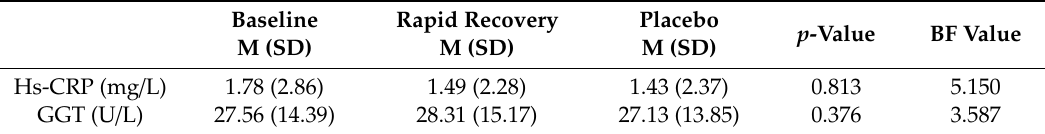
Table 3. High sensitivity C-reactive protein (hs-CRP) and gamma-glutamyl transpeptidase (GGT) levels (means and standard deviations) at baseline and in the Rapid Recovery and placebo conditions. Descriptive data is given in the left columns, while the p value obtained from paired samples t-tests comparing the placebo and active condition, as well as the BF value obtained in case of non-significant di ff erences (i.e., p values < 0.05) are provided in the right columns ( N = 16).